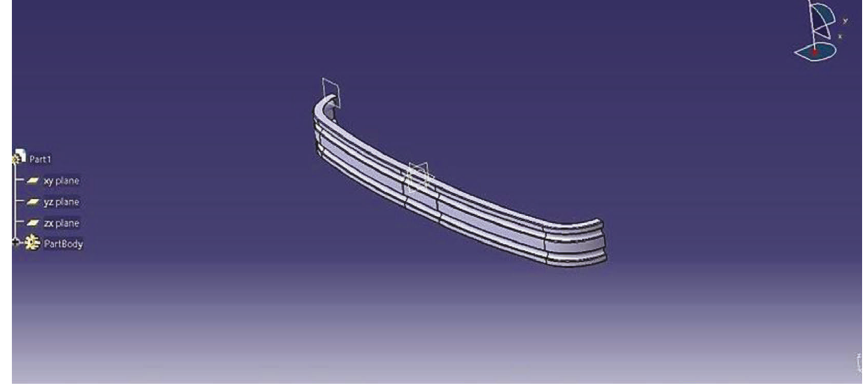
Figure 5: CATIA V5 model of the bumper.